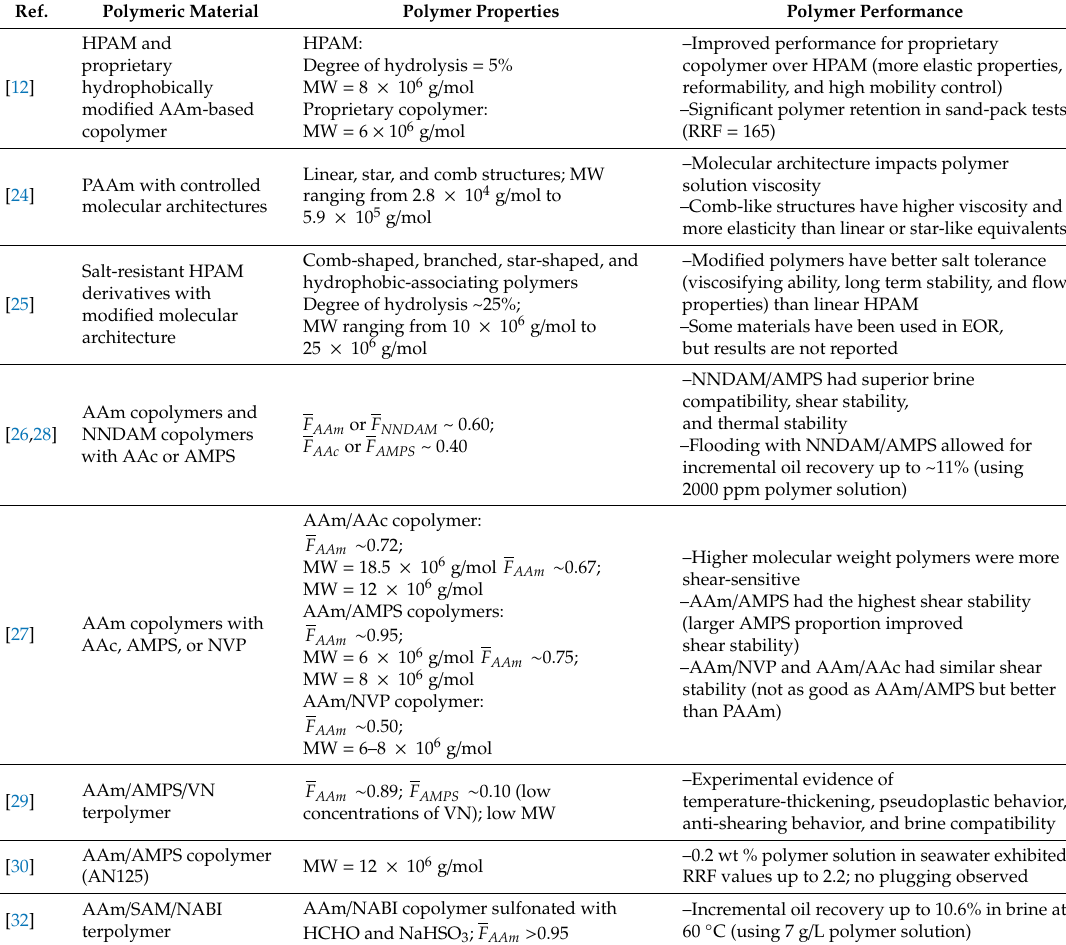
Table 1. Polyacrylamide-based materials for polymer flooding enhanced oil recovery (EOR).